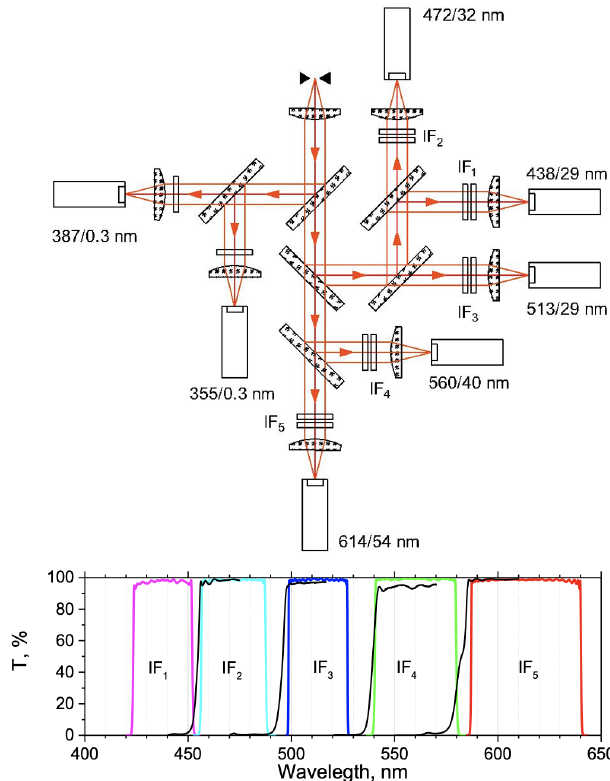
Figure 1. Optical scheme of the receiving module of the lidar to- gether with transmissions of interference filters IF 1 –IF 5 in the flu- orescence channels. Black lines show the transmissions of the 45 ◦ dichroic beam splitters used for the separation of fluorescence spec- tral